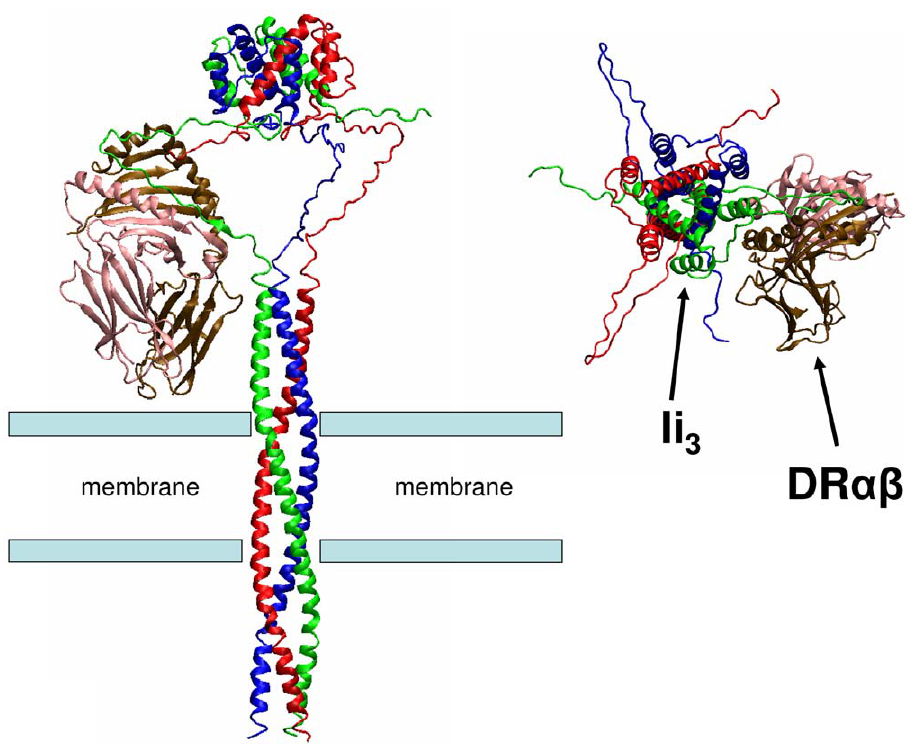
Figure 9. Modeling of MHCII-Ii structure. (left) Molecular model (see Methods section for details) for a pentameric MHCII-Ii oligomer consisting of a trimeric Ii (chains are in blue, red and green cartoons) and one bound MHC-II heterodimer (alpha and beta chains in pink and brown cartoon, respectively). The position of the membrane is indicated (bars representing approximately the lipid-solvent boundary). (right) Top view of the model (from the ER) along the axis of the coiled-coil structure.